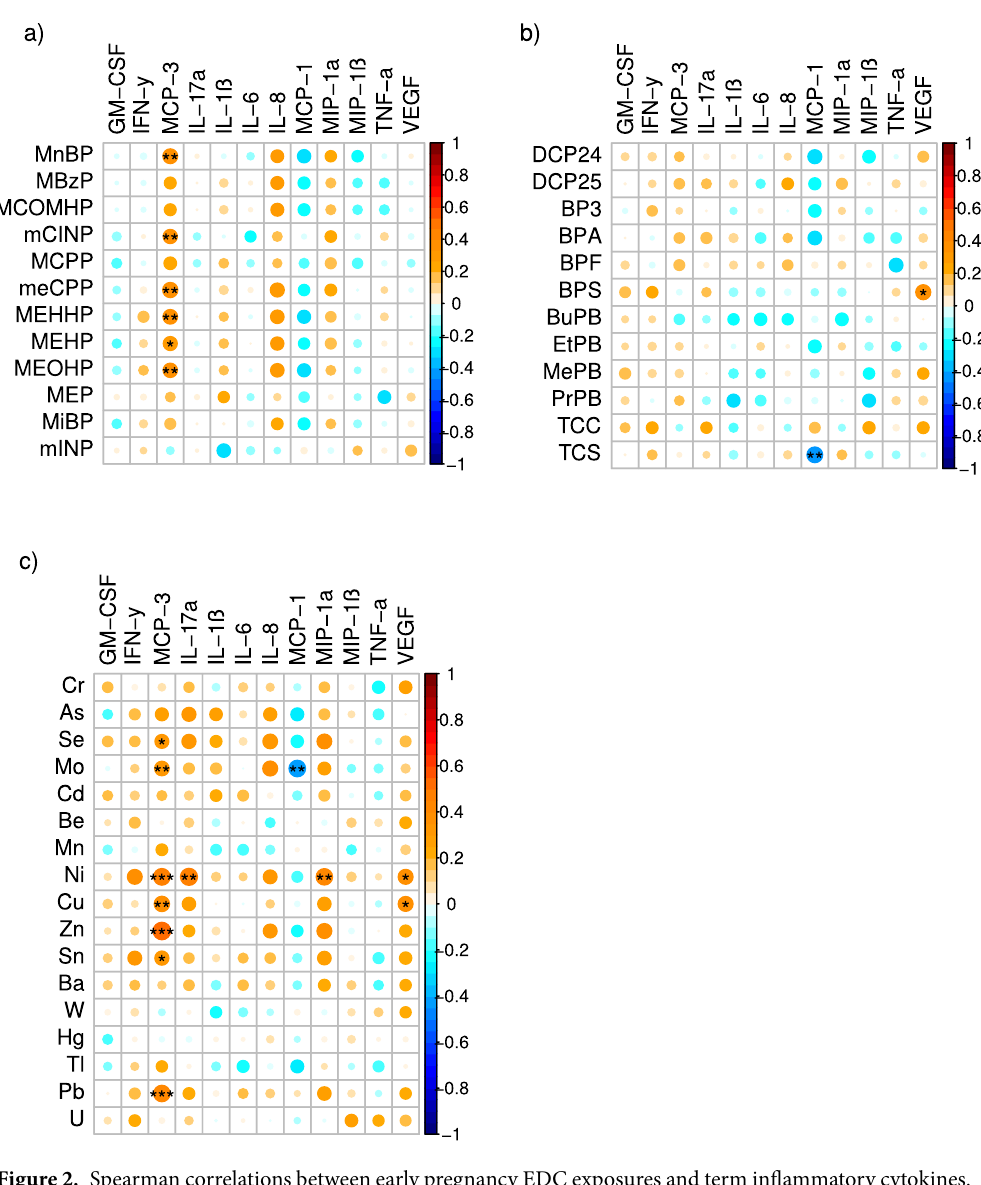
Figure 2. Spearman correlations between early pregnancy EDC exposures and term inflammatory cytokines. Using the color spectrum, the orange color indicates a positive correlation, while the blue color indicates a negative correlation for cytokines with ( a ) phthalates, ( b ) phenols, and ( c ) metals. Circle size reflects the size of the correlation, with larger circles having correlations closer to 1 or − 1. Shade of orange or blue also reflects